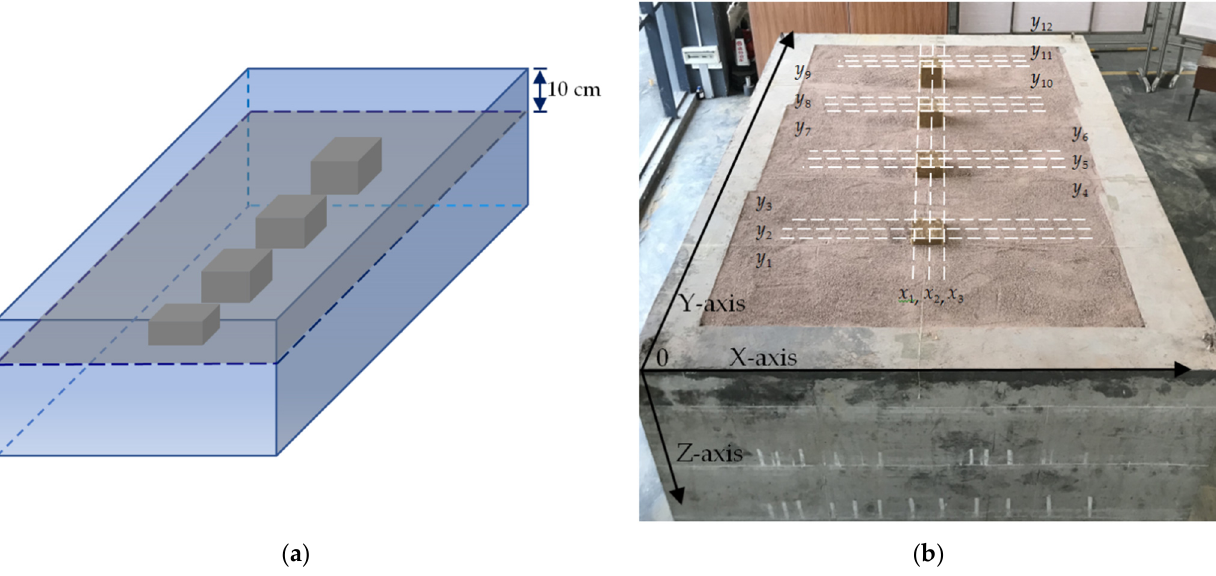
Figure 4. Indoor experiment of GPR detection: ( a ) schematic diagram of four model boxes buried in the sand box; ( b ) fifteen survey lines arranged during GPR testing.